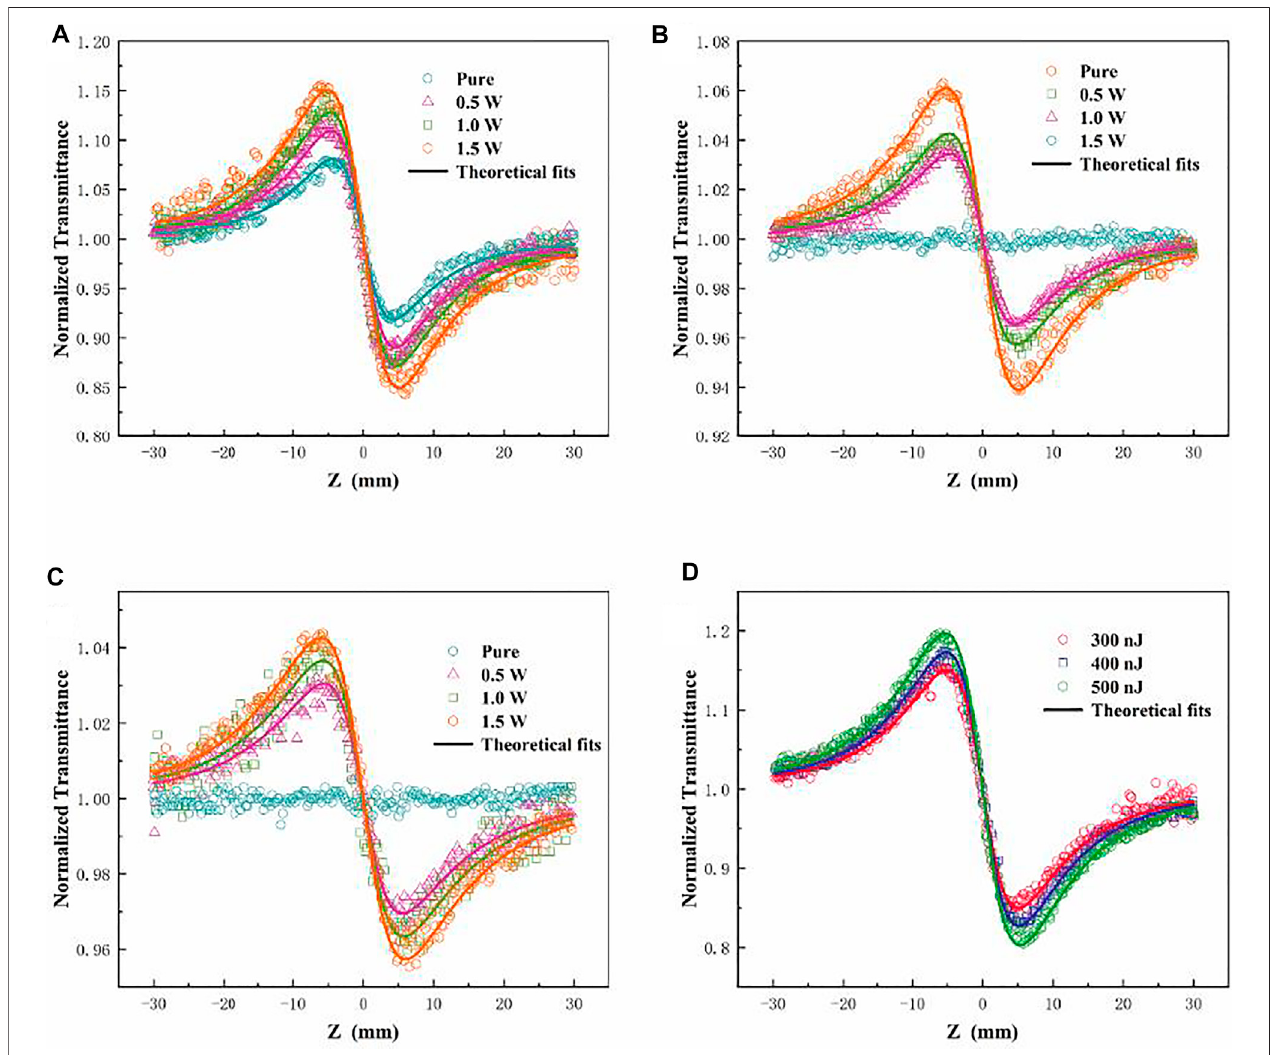
FIGURE 7 | The CA Z-scan signals of the Co-doped Sb 2 Se 3 nano fi lms at 800 (A) , 980 (B) , and 1,030 nm (C) . (D) The CA Z-scan signals of Co-doped Sb 2 Se 3 nano fi lms (1.5 W) at 800 nm under different excitation conditions (300, 400, and 500 nJ).